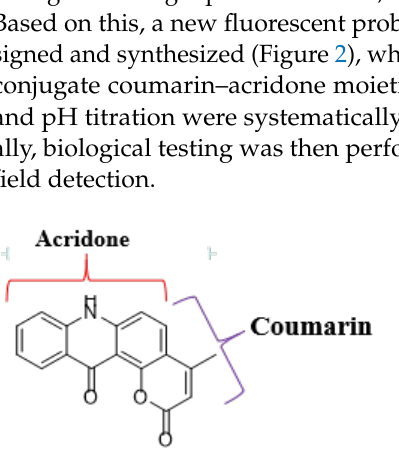
Figure 2. A new structure of coumarin-fused acridone.